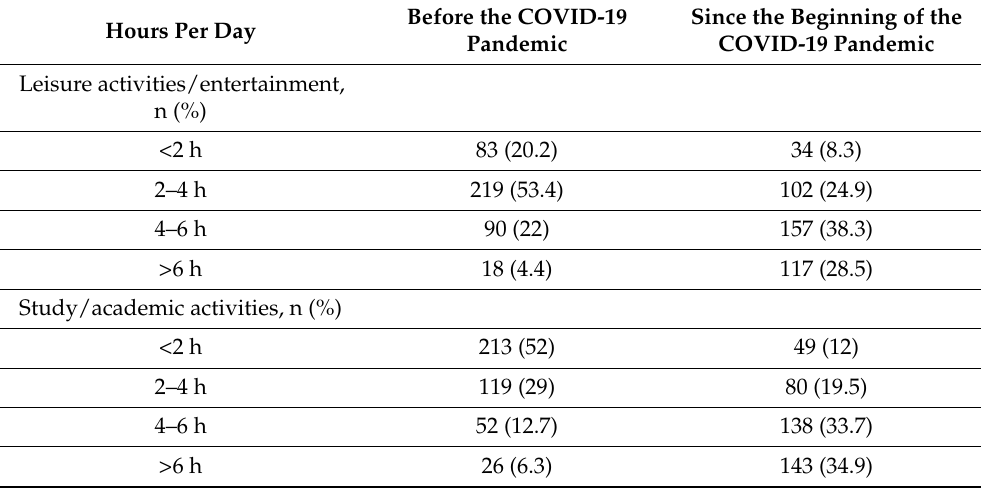
Table 2. Hours per day spent on the internet by young adult university students for leisure activi- ties/entertainment and for study/academic activities before and since the beginning of the COVID-19 pandemic.